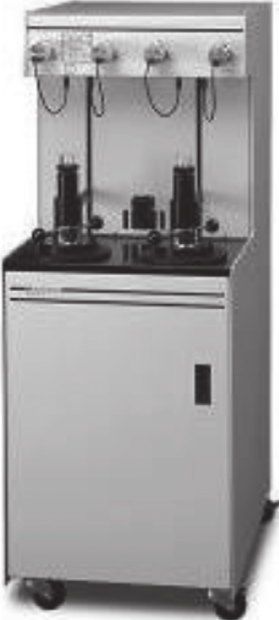
Figure 4: AutoPore V 9600 MIP